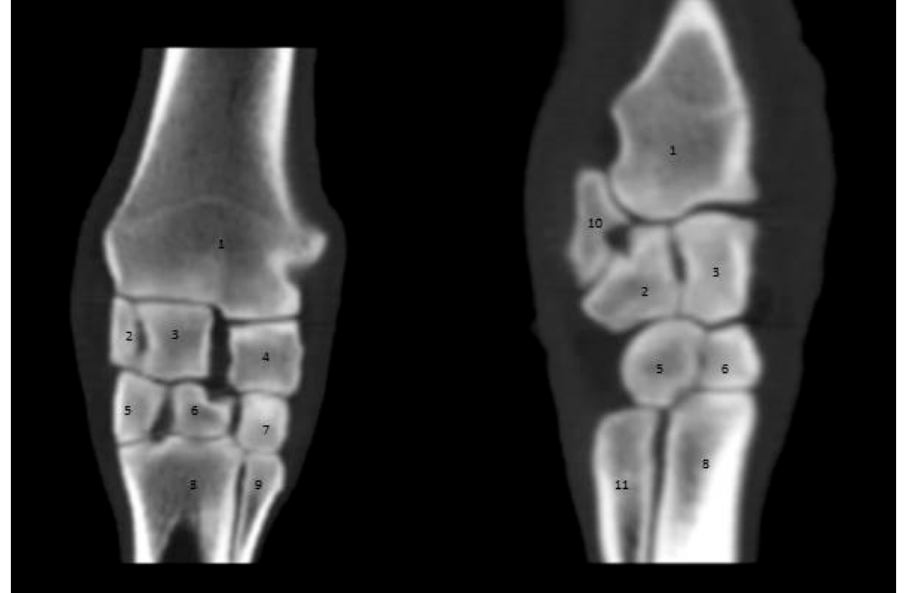
Figure 4. Sagittal computed tomographic scan of the carpal joint in donkeys. (1) Distal radius extremity. (2) Ulnar carpal bone. (3) Intermediate carpal bone. (4) Radiocarpal bone. (5) Fourth carpal bone. (6) Third carpal bone. (7) Second carpal bone. (8) Third metacarpal bone. (9) Second metacarpal bone. (10) Accessory carpal bone. (11) Fourth metacarpal bone.